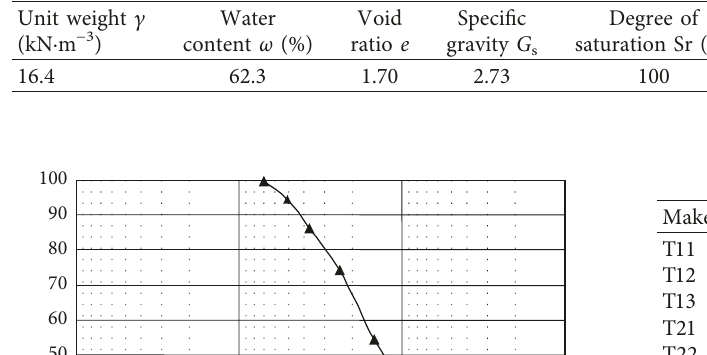
Table 1: Geotechnical properties of clay.